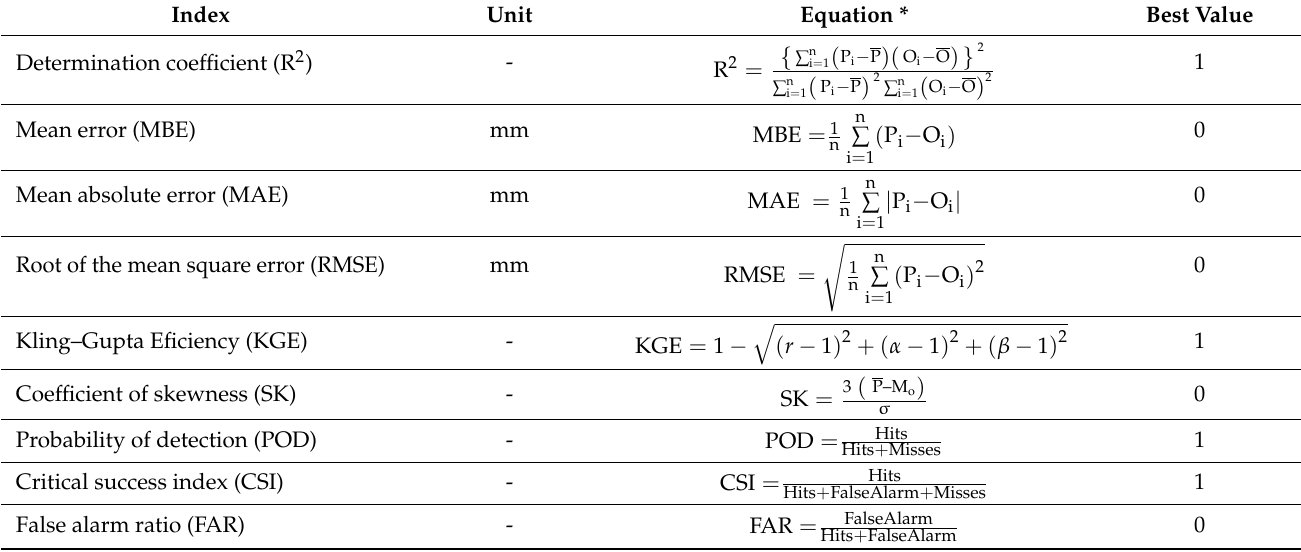
Table 1. Summary of statistical indices used to evaluate the satellite precipitation